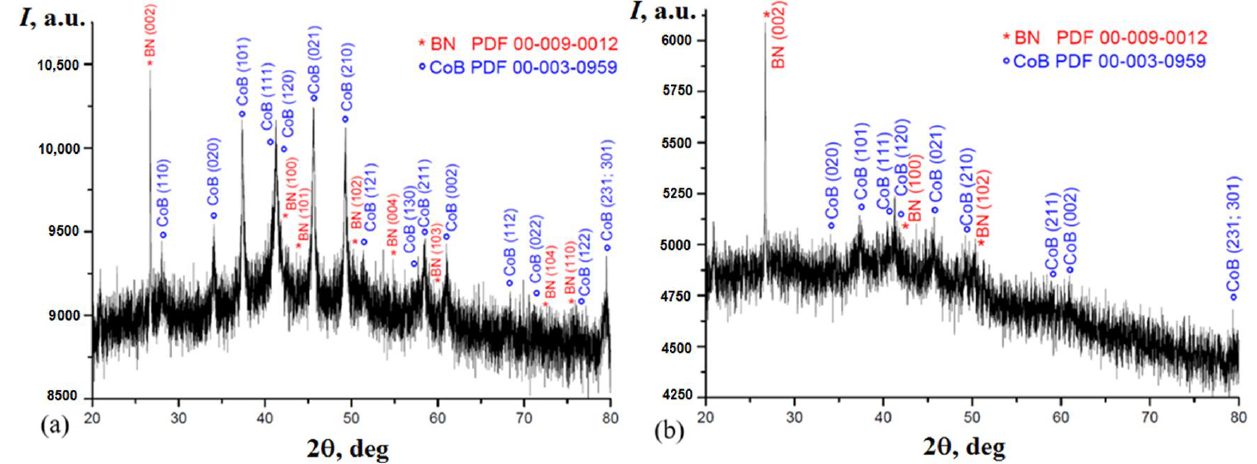
Figure 6. X-ray powder diffraction pattern for samples ( a ) 1a and ( b ) 2a .